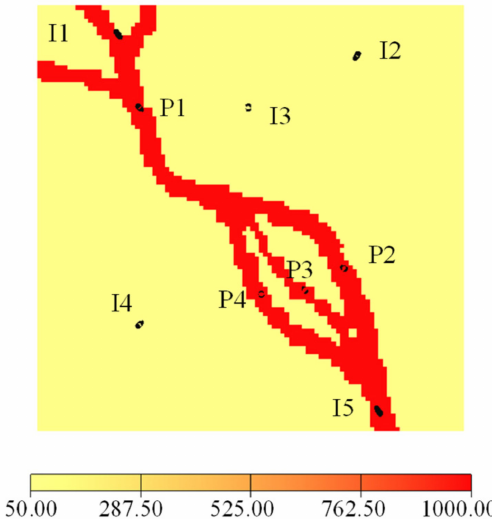
Figure 9. Permeability field of the braided river reservoir case.